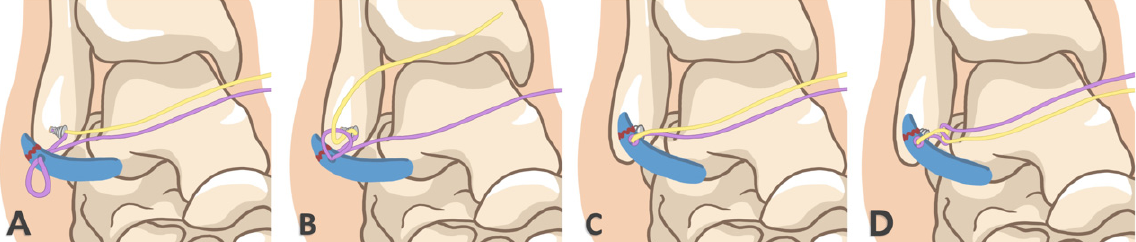
Figure 4. Loop principle: ( A ) Pass the purple wire with the anchor nail through the ligament to form a loop on the opposite side. ( B ) Pass the yellow wire with the anchor nail through the loop. ( C ) Tighten the purple wire through the ligament and then the yellow wire to wrap the ligament and pull it towards the bony surface. ( D ) Finally, the ligament repair is completed by knotting and fixing.